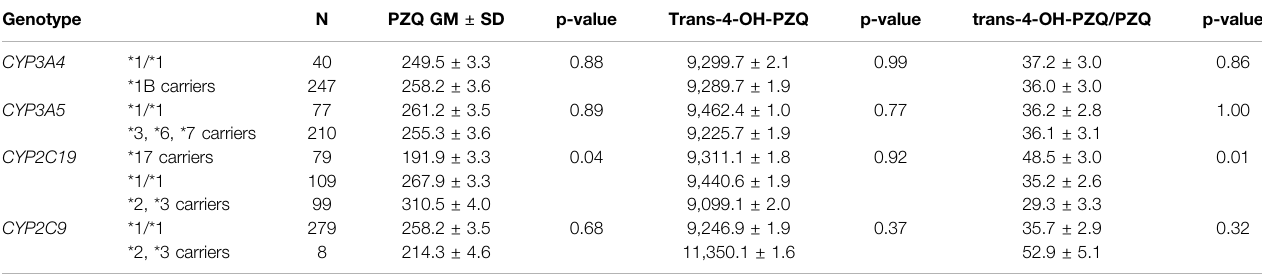
TABLE 3| Comparison of the geometric means ofPZQ, trans -4-OH-PZQ concentrations (ng/mL) and metabolic ratio(t rans -4-OH-PZQ/PZQ) between CYP450genotypes using One-way ANOVA. Genotype